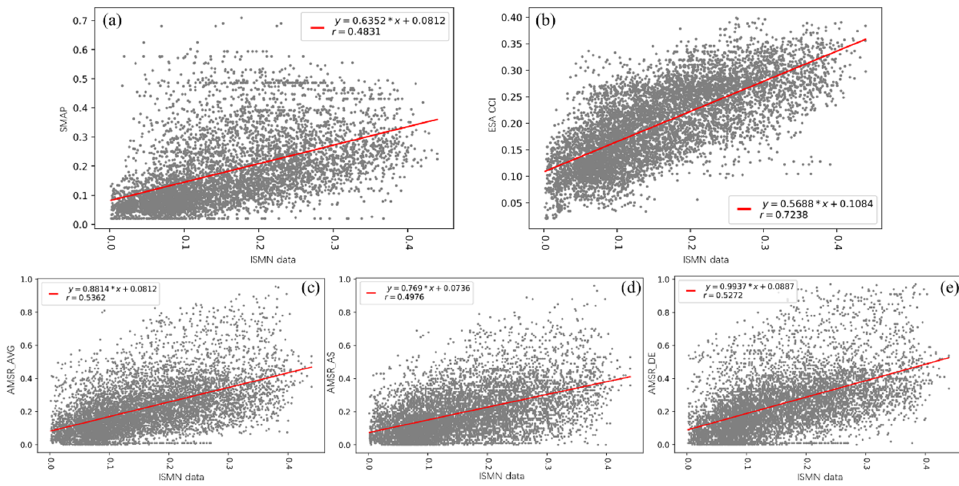
Figure 2. Scatter plots between several products and ISMN data (( a ) SMAP, ( b ) ESA CCI, ( c ) AMSR2 average product (AMSR_AVG), ( d ) AMSR2 ascending product (AMSR_AS), and ( e ) AMSR2 de-